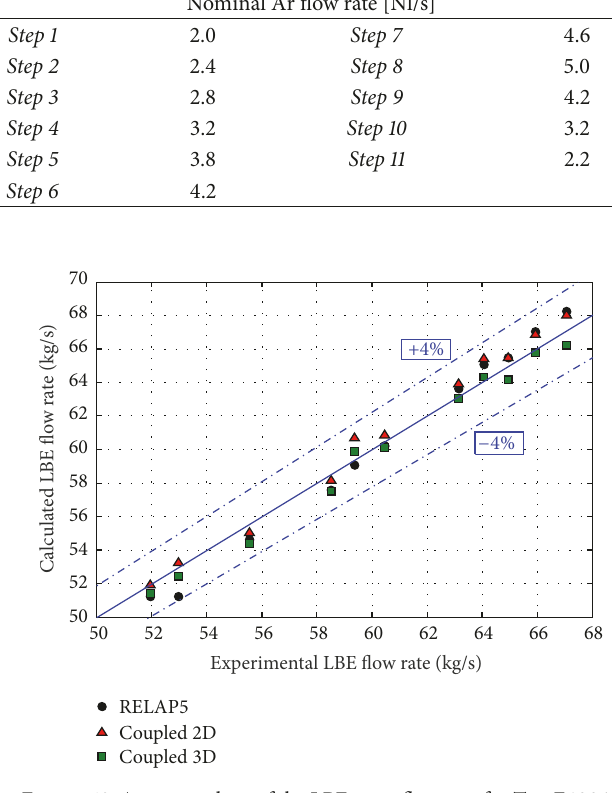
Figure 13: Average values of the LBE mass flow rate for Test F400 in CIRCE